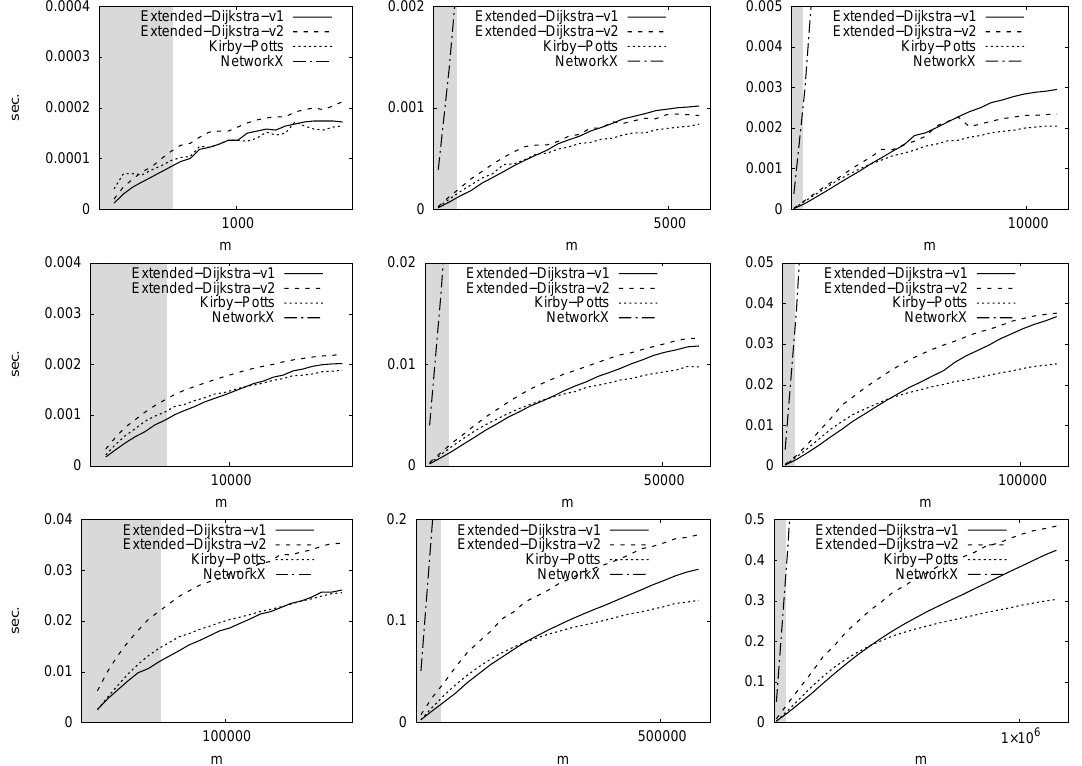
Figure 8. CPU times required to produce a shortest path tree from a single source using planar graphs of differing densities. Rows show n values of 100, 1000 and 10,000 respectively; columns consider k -values of 3, 10 and 20 respectively. Note that results for NetworkX are not displayed in some charts because their CPU times exceed the chosen vertical